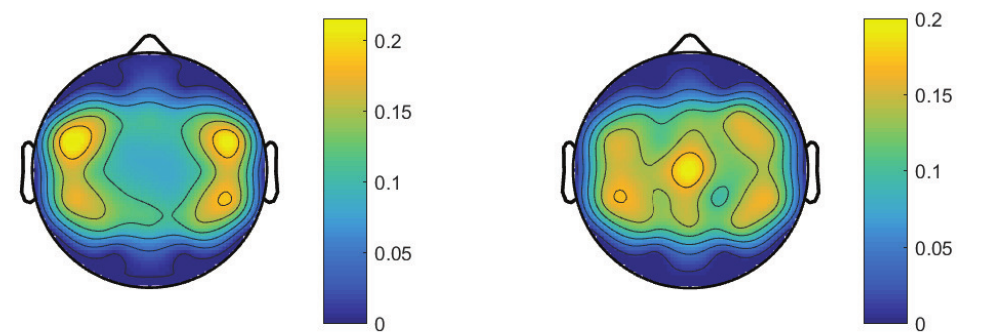
Figure 8. Scalp topographies to show the feature representation of the SVM-based method ( left panel ) and the CNN-based method ( right panel ) for the decoding of lower-limb extension and flexion MI with 32 EEG